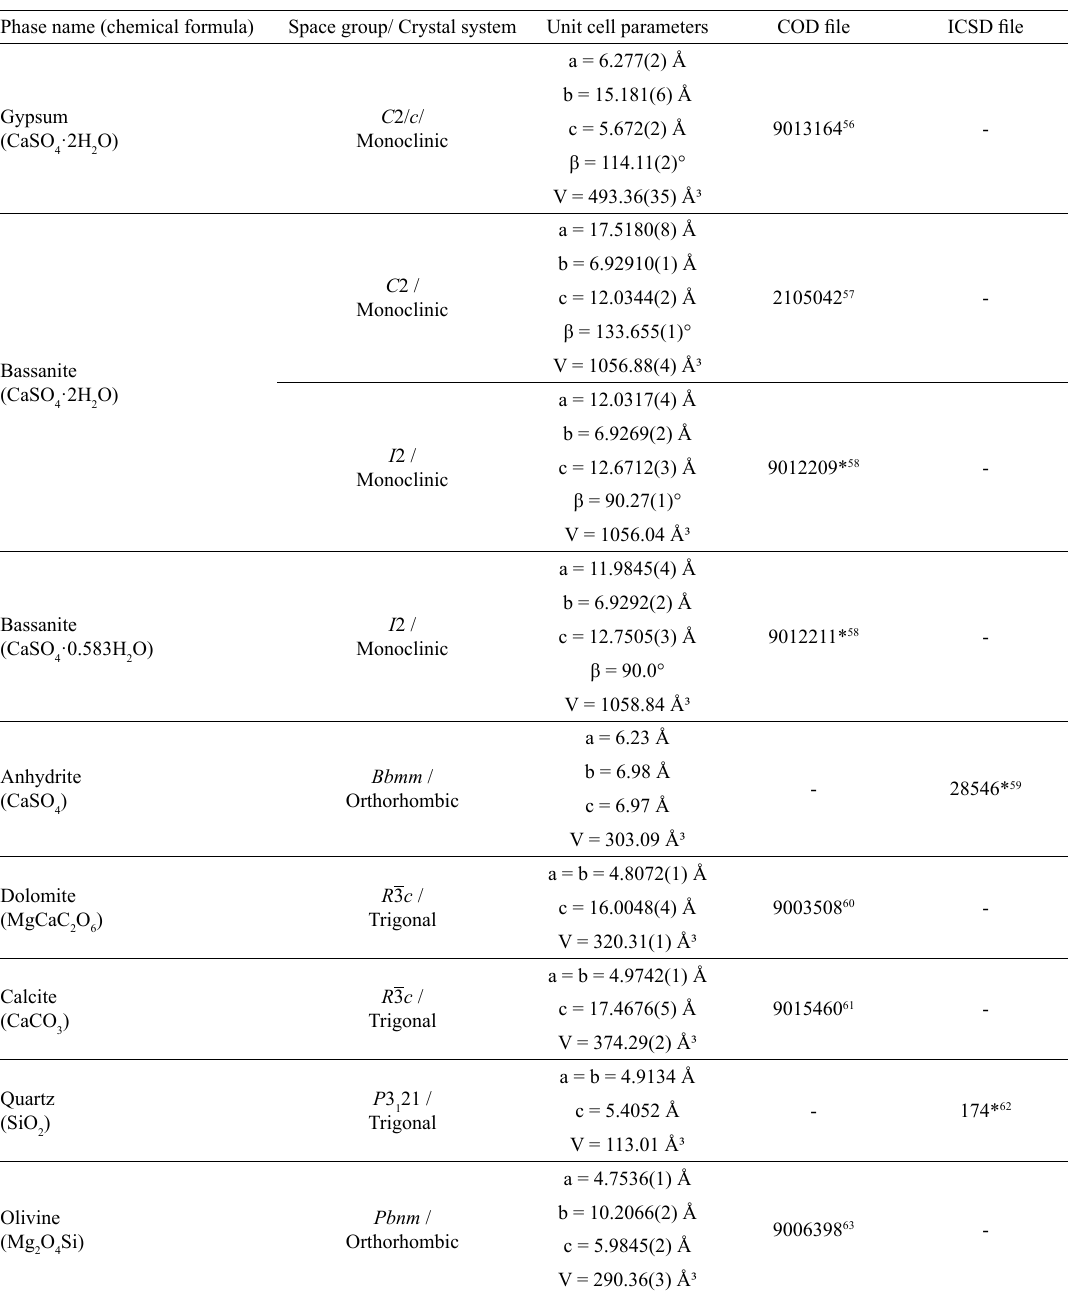
Table 2. Information on the data sheets used in Rietveld refinements obtained from COD and